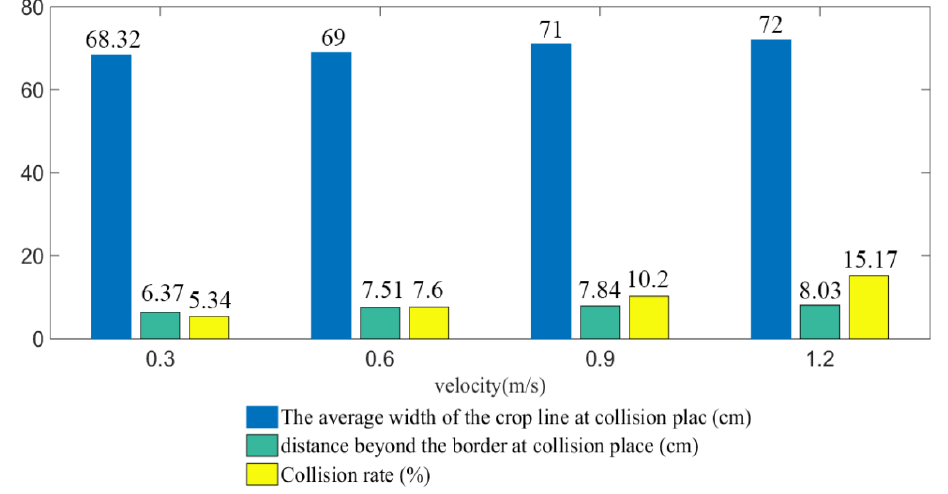
Figure 13. A histogram of the stability of the system in the case of a vehicle running at different speeds.